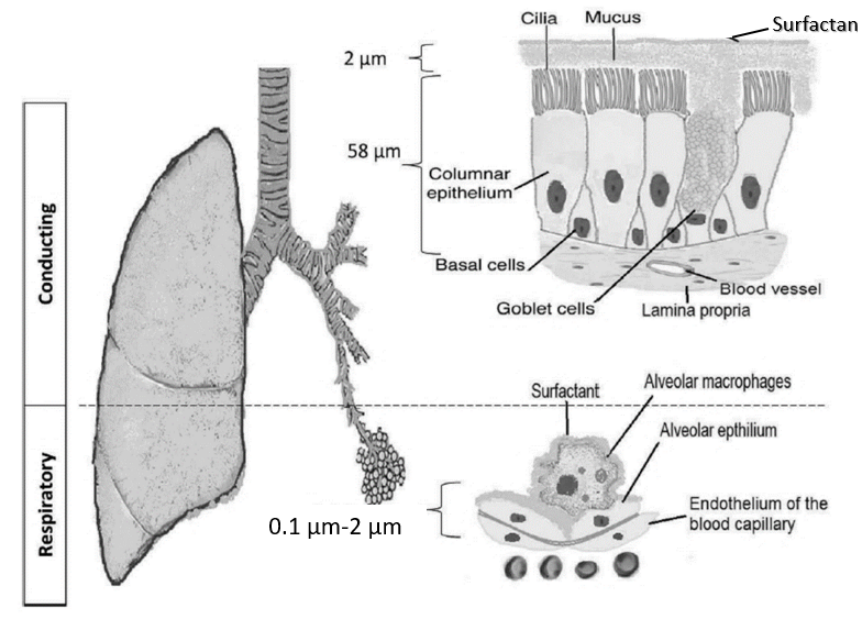
Figure 1. The pulmonary barrier structure in the conducting and respiratory airways [5].